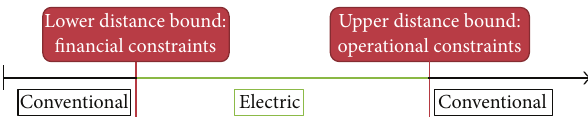
Figure 1: The paradox of the battery electric vehicle. Source: own